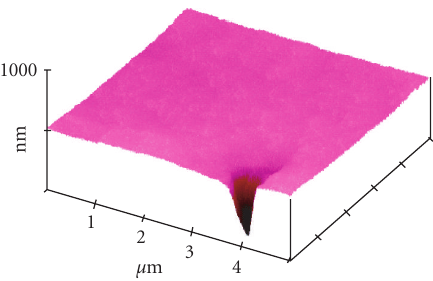
Figure 23: Shear-force AFM topography of a human tooth on a mi- crotome cut orthogonal to the tubuli direction showing deep pene- tration of the sharp tapered tip.